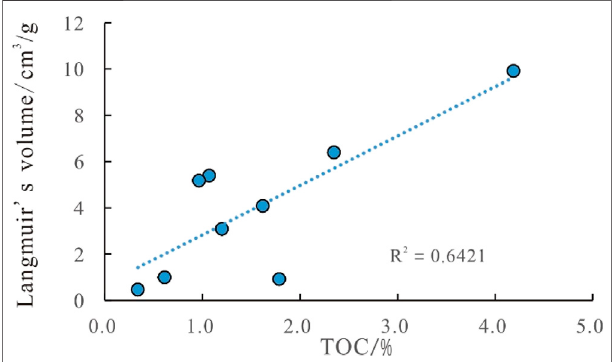
FIGURE 8 | Correlation between TOC and Langmuir ′ s volume of methane for Shan 23 shale.